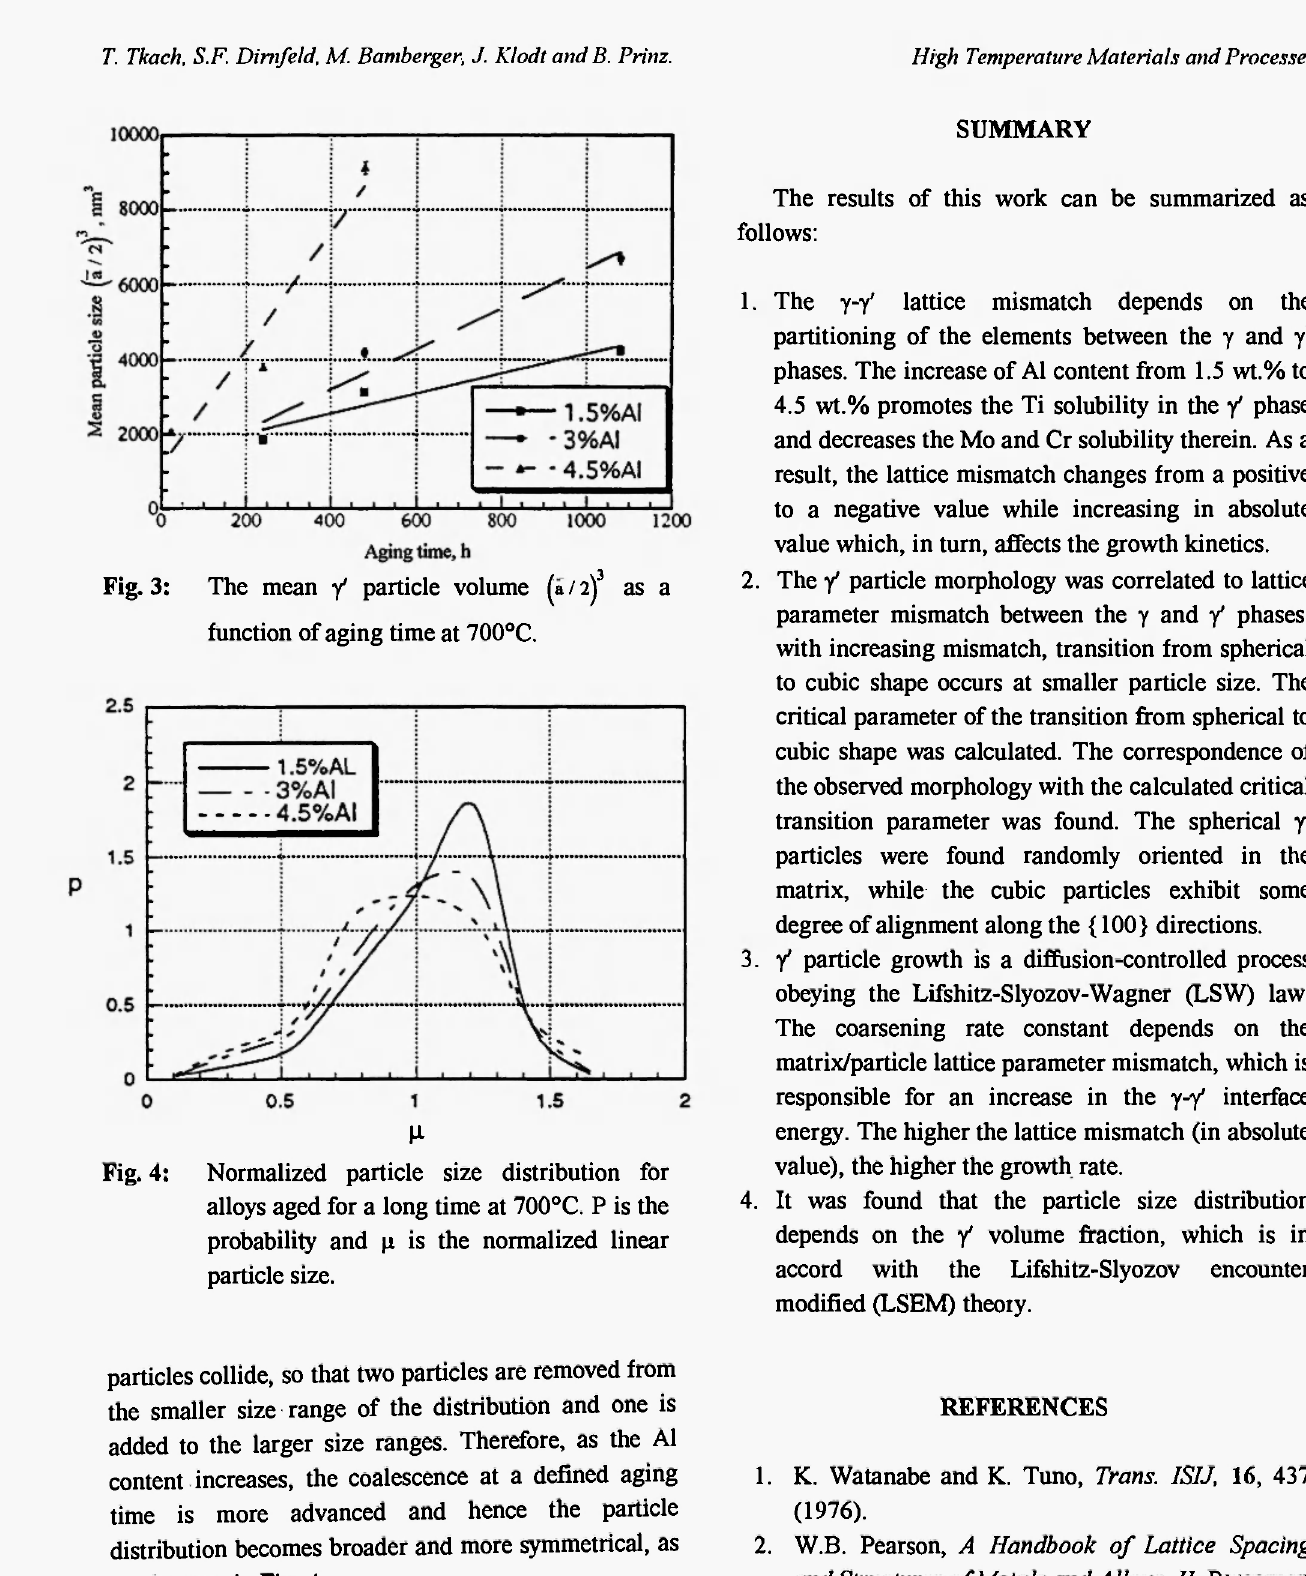
particles collide, so that two particles are removed from the smaller size range of the distribution and one is added to the larger size ranges. Therefore, as the Al content increases, the coalescence at a defined aging time is more advanced and hence the particle distribution becomes broader and more symmetrical, as can be seen in Fig.